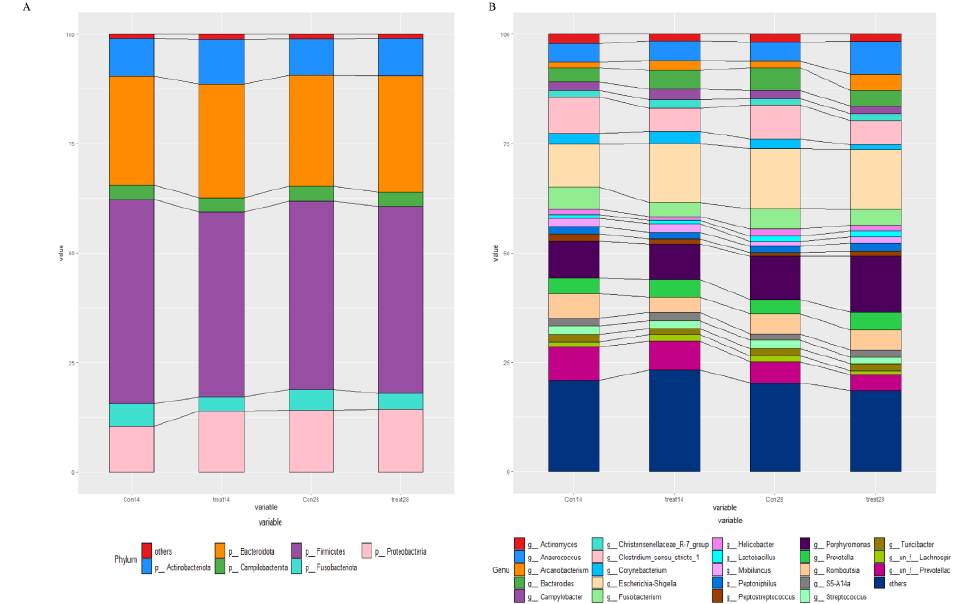
Figure 4. Effects of MSFAs during gestation on the rectal swab microbiota compositions of sows. The relative abundances of different phyla ( A ) and genera ( B ) in the rectal swab microbiota of control and treatment group sows at day 14 and day 28 of gestation. N = 11.